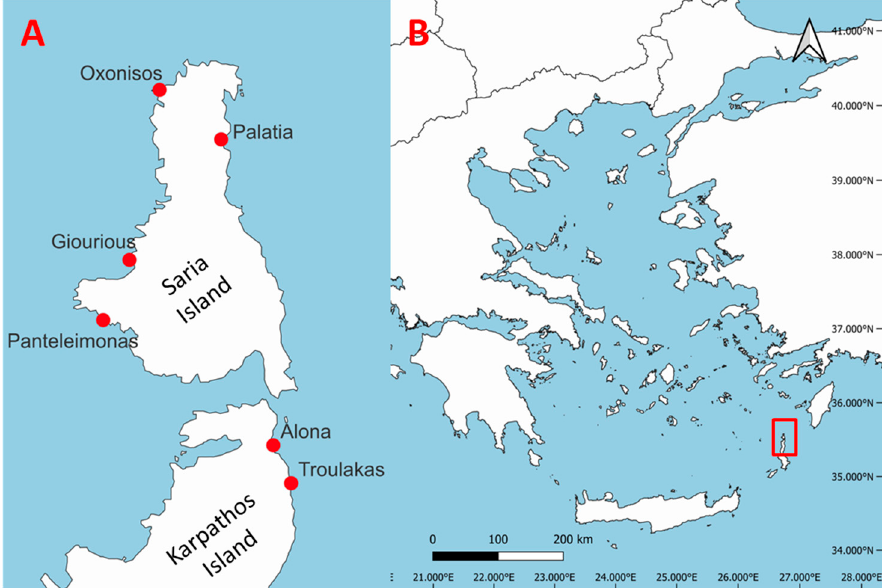
Figure 1. Location of the studied marine caves on the north coasts of Karpathos and Saria Islands ( A ) and their location in Greece, Eastern Mediterranean ( B ). Table 1. Geomorphological and topographic characteristics of the six studied marine caves. Sub., fully submerged; Semi-sub., semi-submerged.